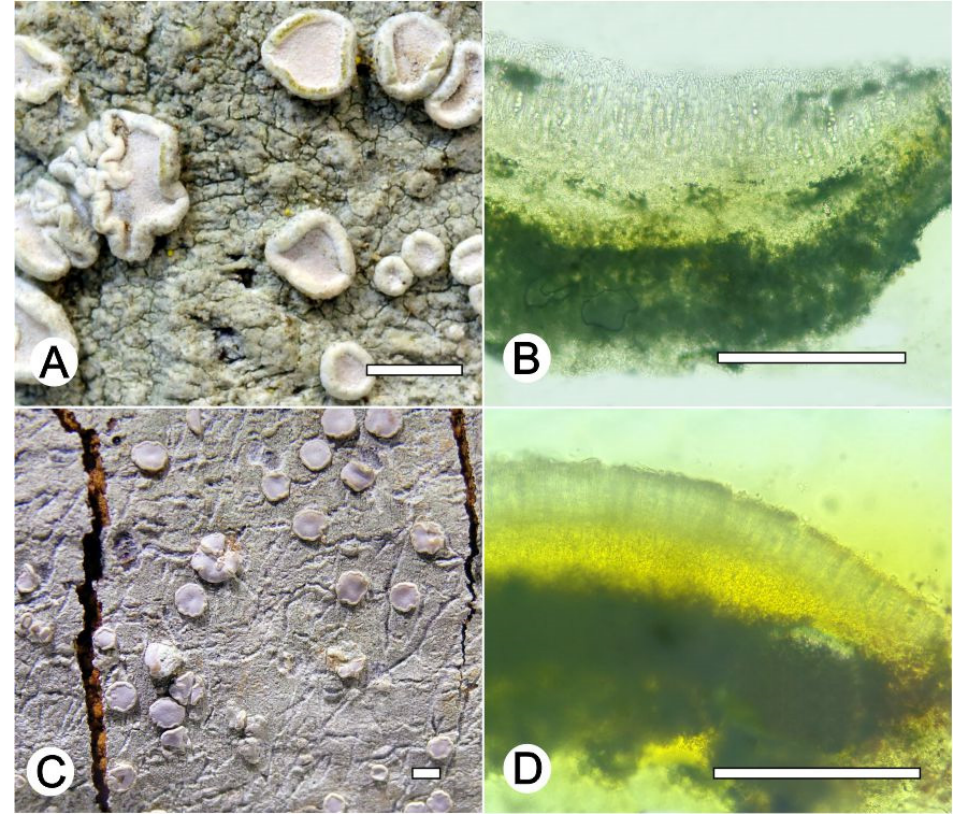
Figure 7. Lecanora neomerrilli nom. nov. ( A ) Thallus with ascomata (ISE-38146); ( B ) Apothecial section after KOH treatment (holotype ISE-38146); ( C ) Thallus with ascomata (ISE-52228); ( D ) Apothecial section after KOH treatment (holotype ISE-52228). Scale bars: ( A – C ), 1 mm; ( B – D ), 100 µ m. MycoBank MB